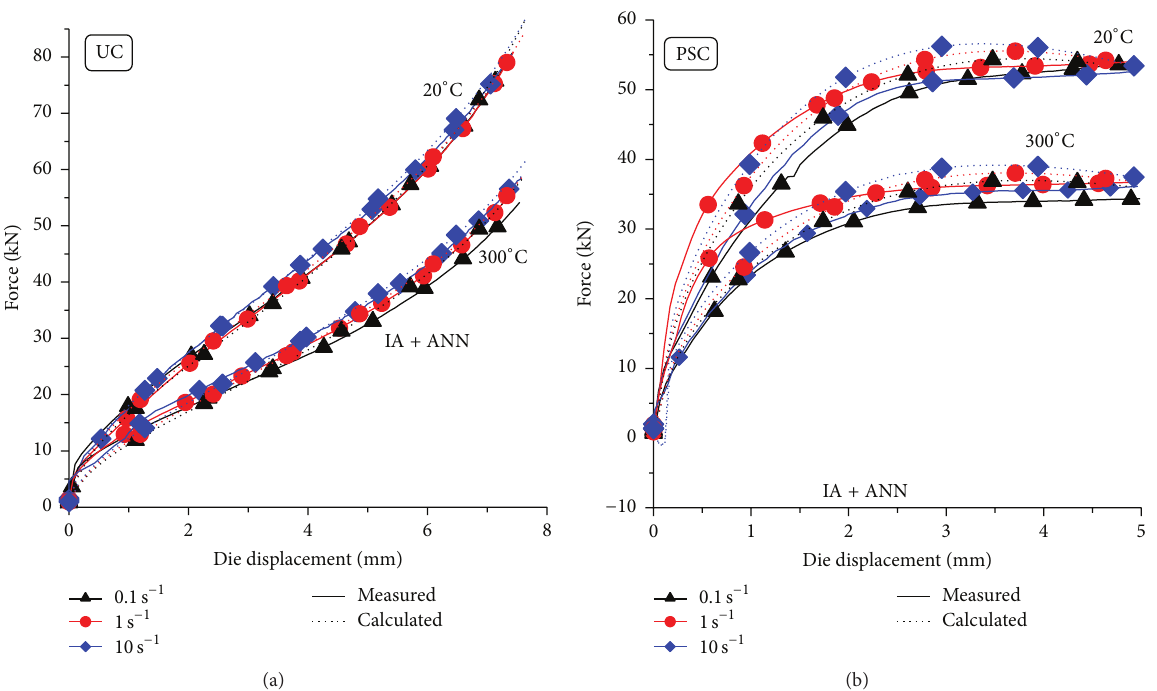
Figure 22: Comparison of forces measured in the UC (a) and PSC (b) tests and calculated by the FE code with (3) with the coefficients obtained from the inverse analysis with the metamodel for both of these tests (row 2 in Table